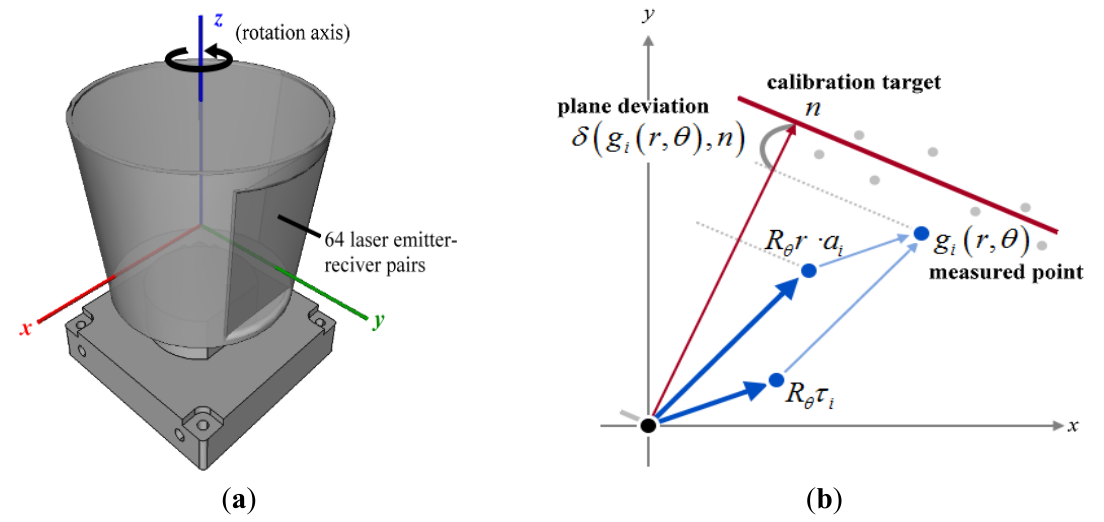
Figure 3. ( a ) coordinate system of the Velodyne LiDAR system; ( b ) geometric relation of laser intrinsic parameters in linear representation, a calibration plane, and the